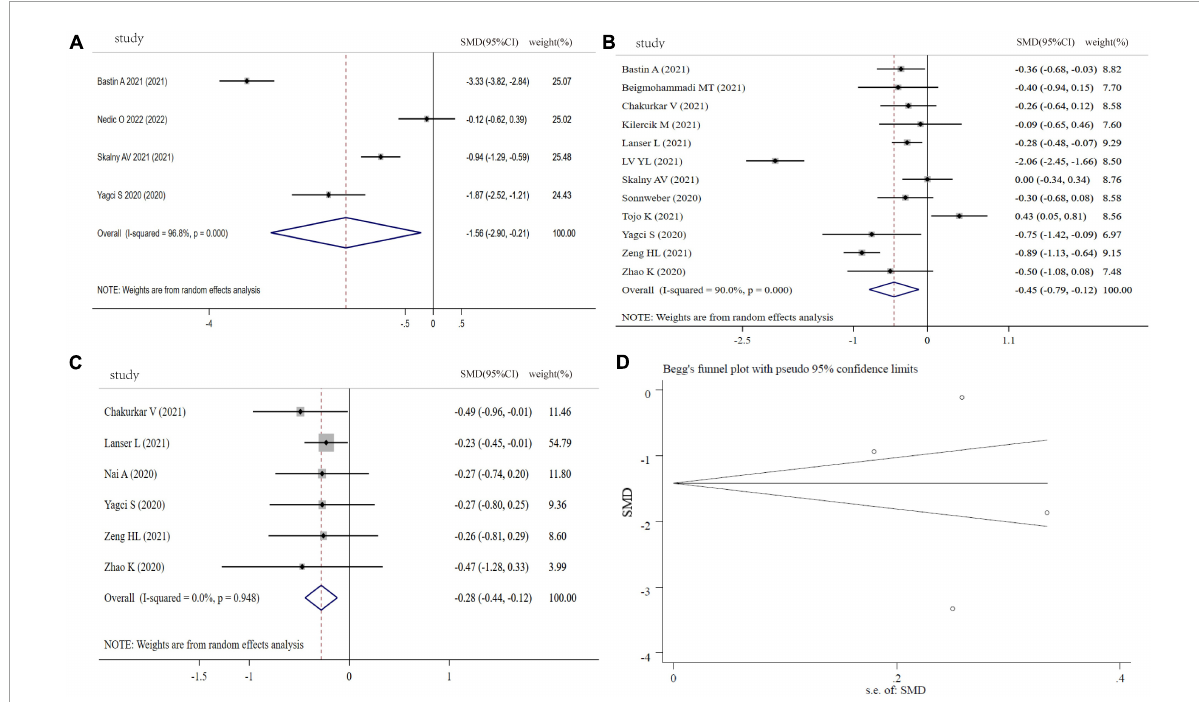
FIGURE3 Forest plot of Fe levels. (A) Fe levels between COVID-19 patients and controls; (B) Fe levels between severity status and non-severity status in COVID-19 patients; (C) Fe levels between non-survivors and survivors in COVID-19 patients; (D) funnel plot of the meta-analysis on Fe levels between COVID-19 patients and